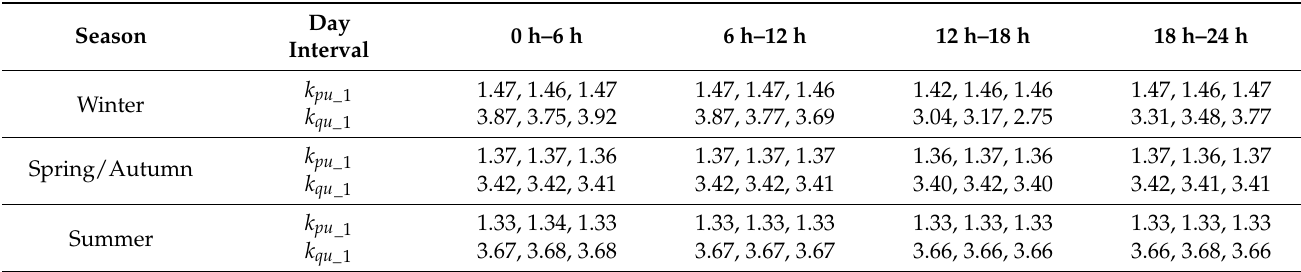
Table 6. Parameters k pu and k qu in different seasons and day intervals calculated from average meteorological variable A p ( k pu_ 1 and k qu_ 1 ), of a working weekday, Saturday, and Sunday, as listed